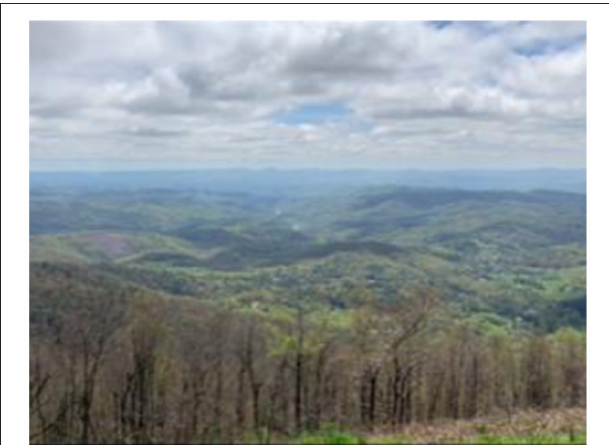
FIGURE 9 | “Physical activity in the lives of my family and friends: Last summer, my family and I hiked a mountain and once we reached the top, we took this picture. Doing physical activities with my family is fun and also helps me stay active.” (Julia,